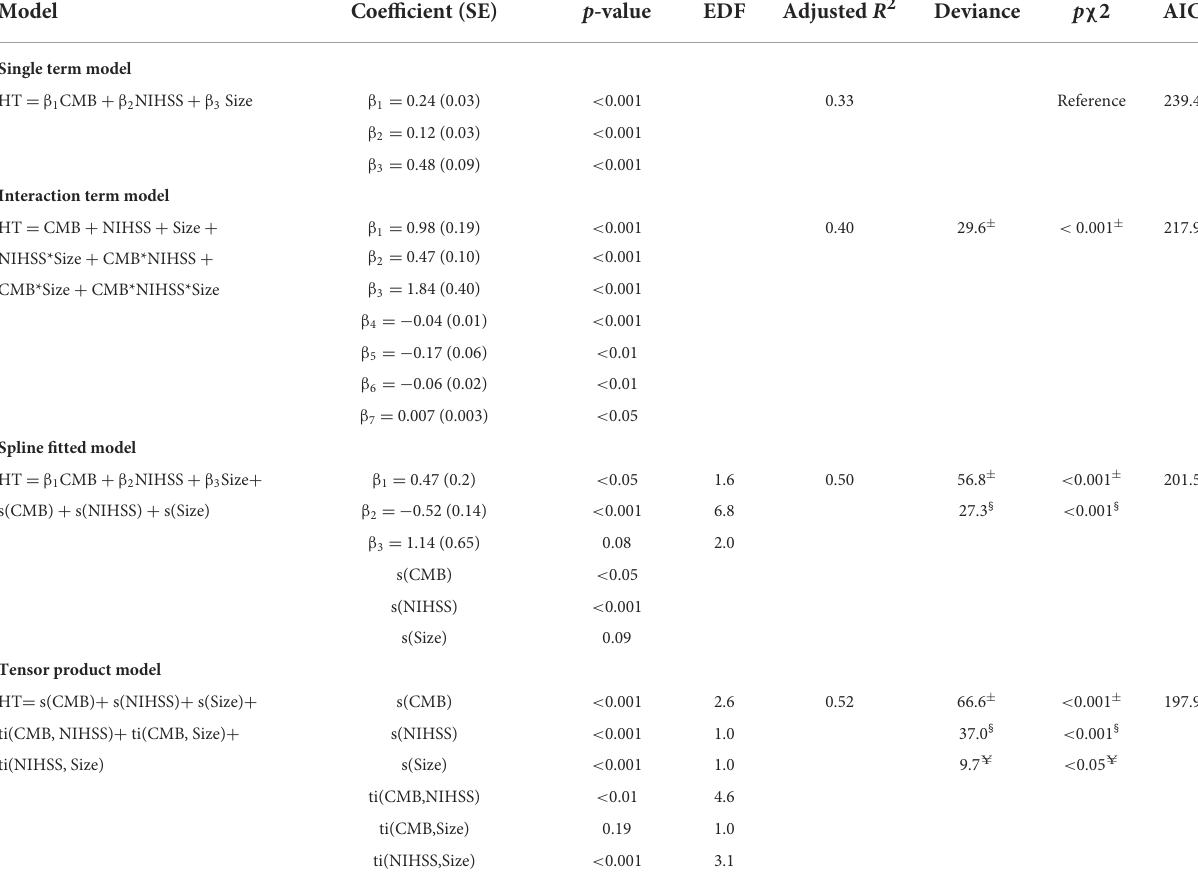
TABLE 3 Fitted GAM models to examine predictors linearity and